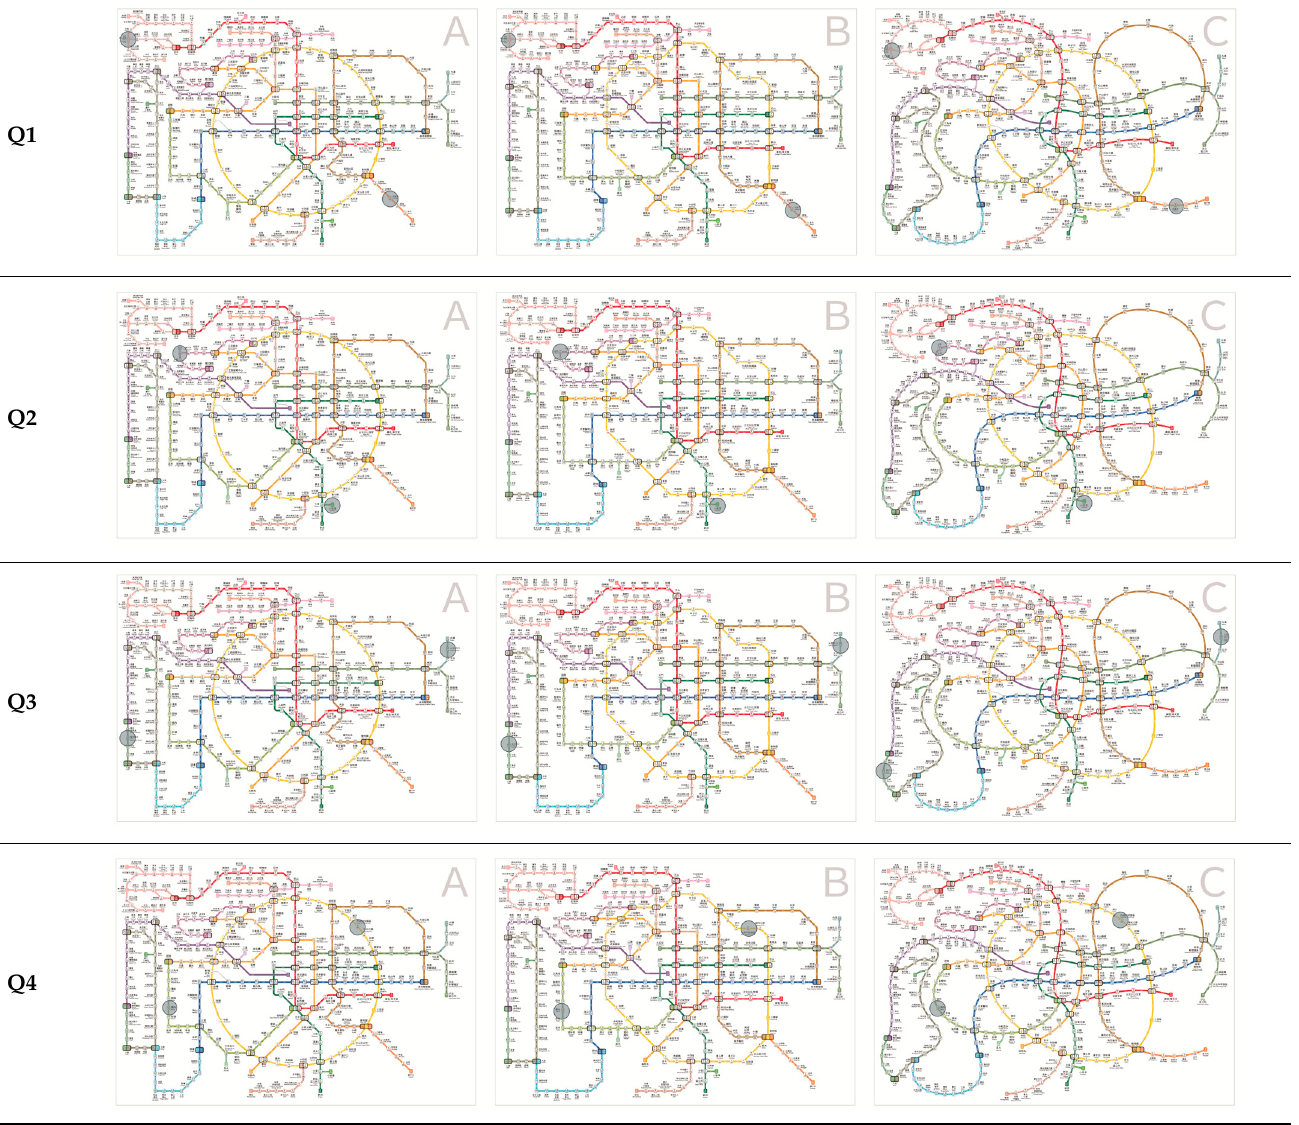
Table 8. Four route planning tasks with designated start and end stations on different route maps. Q1 Q2